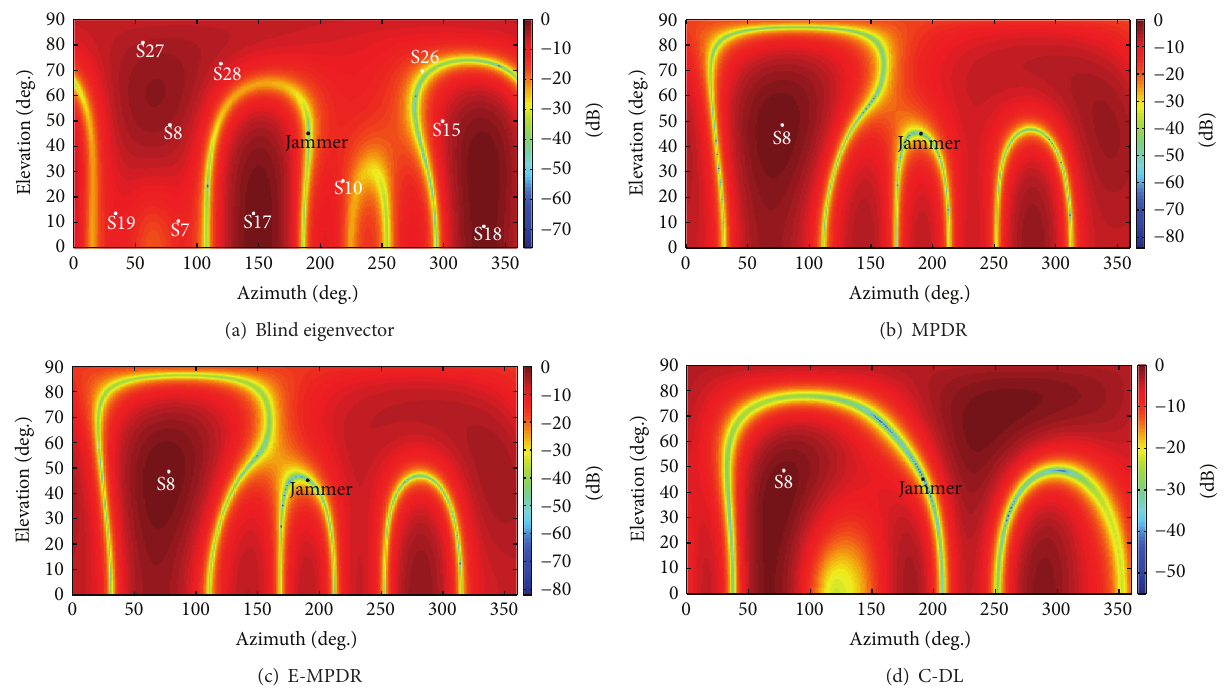
Figure 8: Normalized antenna array gain patterns at the interference frequency for different methods (PRN8—Scenario 2).